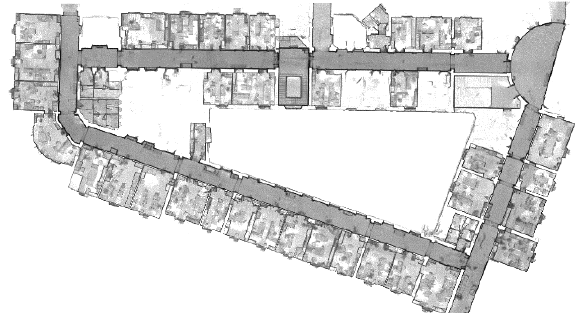
Figure 3: Test 3, particular of the Blueprint